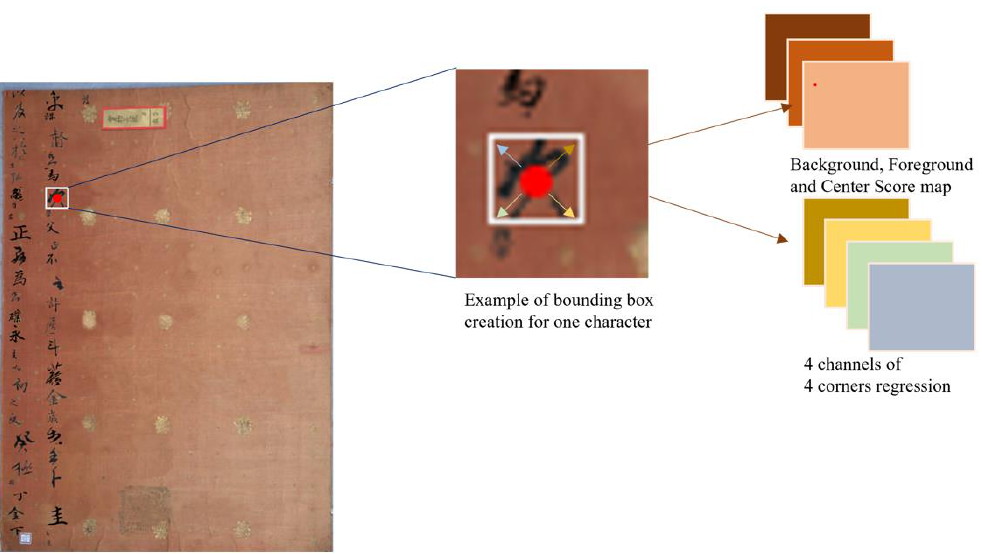
Figure 2. The process of automatically generating the bounding box from the center is referenced as a principle to regress to the four corners. This is based on a multi-channel procedure in which one channel is a heatmap finding the center of the character (red dot), two channels are for background and foreground classification, and four channels are for regression to the four corners of the bounding box.